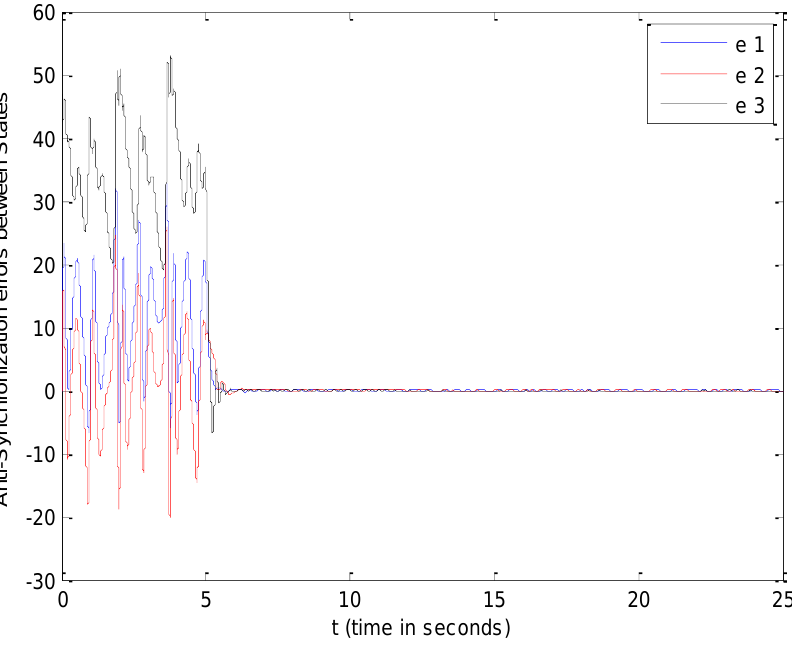
Figure 1. Synchronization error between the states of master and slave systems with 𝛼 2, and 3, and time delay 𝜏 = 5 s.